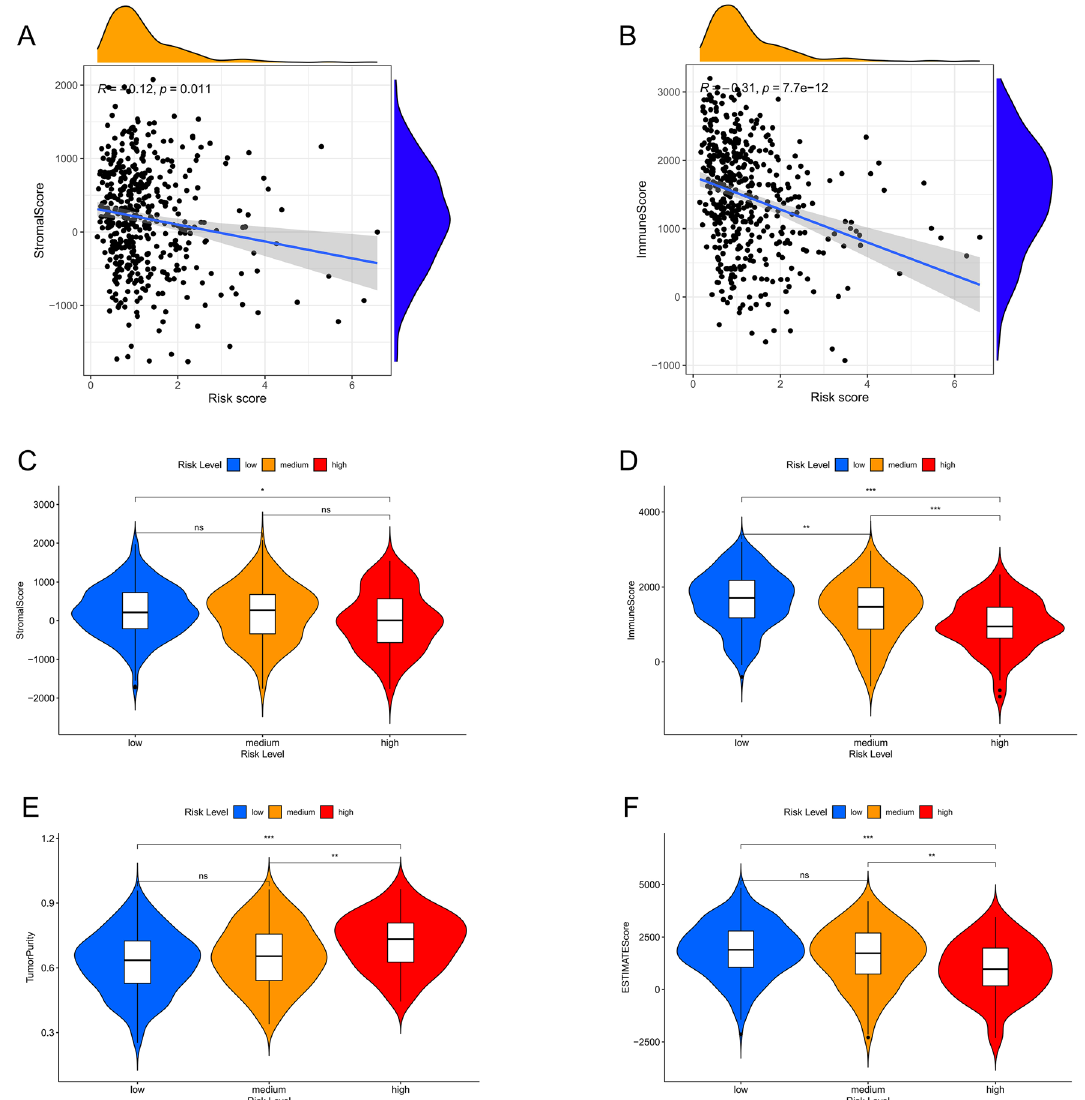
Figure 6. Correlation analysis between prognostic model and tumor microenvironment using R software. ( A ) Spearman analysis between stromal score and risk score. ( B ) Spearman analysis between immune cell score and risk score. ( C – F ) Differences in stromal score ( C ), immune scores ( D ), tumor purity ( E ), estimate score ( F ) between risk groups. * p -value < 0.05, ** p -value < 0.01, *** p -value <